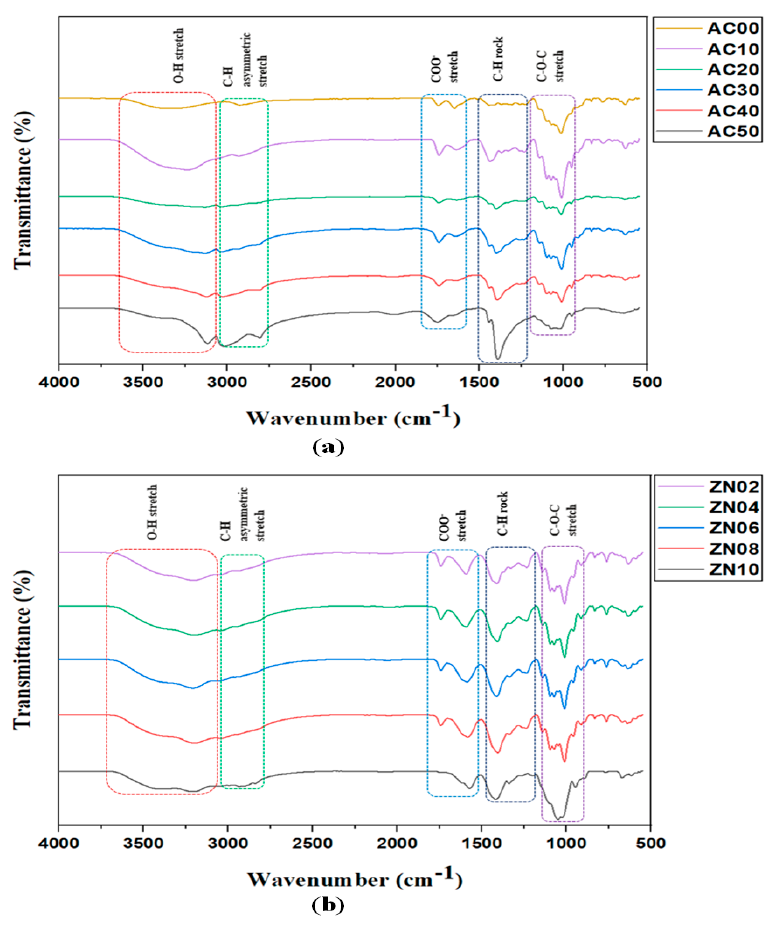
Figure 2. FTIR spectra at 500 to 4000 cm − 1 for ( a ) MC/PC/NH 4 Cl SPE ( b ) MC/PC/NH 4 Cl/ZnO